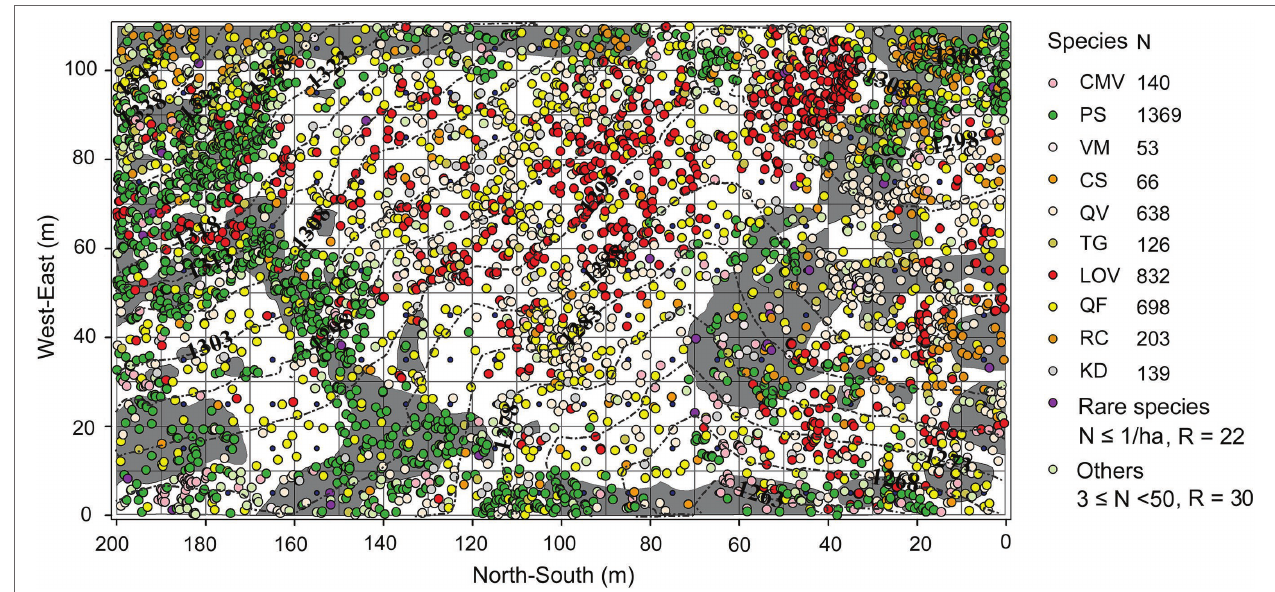
FIGURE 1 | Species composition and distribution of rock and soil at the study site. Gray and white background colors represent rock and soil, respectively. The colored circles represent tree species, while the black dashed lines represent contours. CMV = C. macrophylla , PS = P. strobilacea , VM = V. montana , CS = C. septentrionale , QV = Q. variabilis , TG = T. gymnanthera , LOV = L. ovalifolia , QF = Q. fabri , RC = R. chinensis , KD = K.